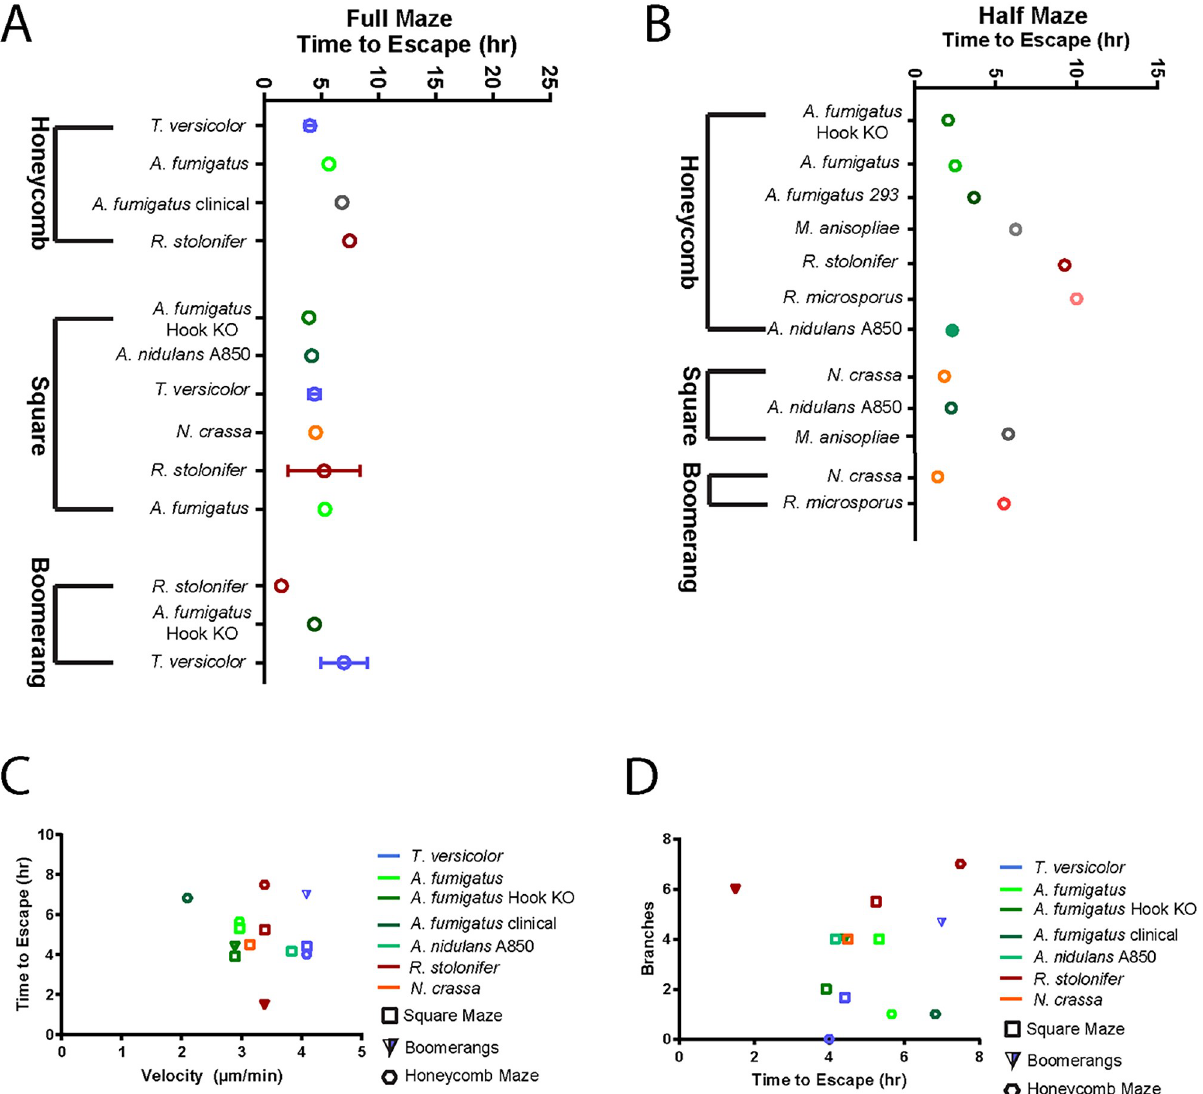
Fig 5. Maze escape analysis. The average time it took to escape each maze is displayed, broken down by individual fungi and maze type. (A) The data for fungi that completed entire mazes is shown. (B) Data for fungi that did not complete the full mazes but completed at least half are also shown. (C) Fungi that completed entire mazes are plotted comparing average time to escape vs. average straight-line velocity (from Fig 2). (D) Average branch number vs. average time to escape. Error bars represent standard deviation.